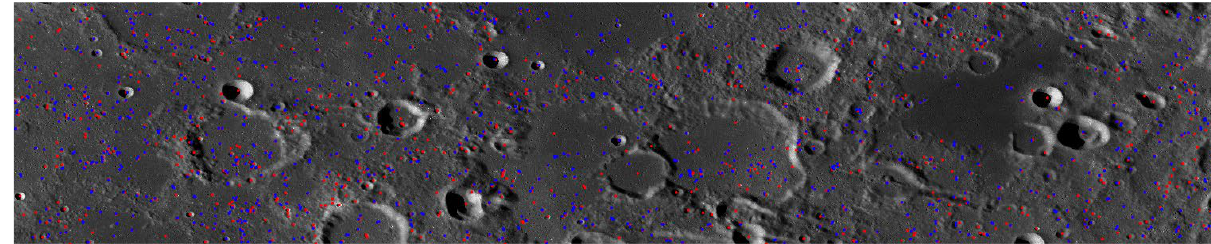
Figure 3. A comparison of the crater detection results between the proposed method and Robbins’ data set (diameter>1000m)